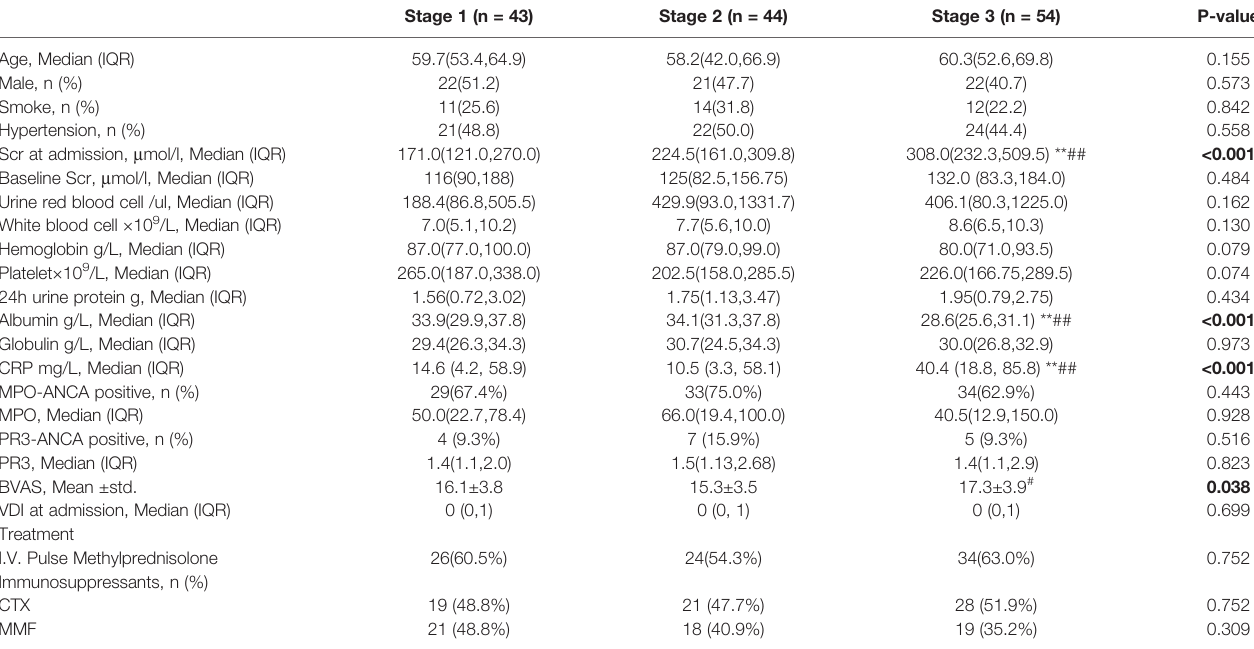
TABLE 1 | Clinical and laboratory data of AAV patients in different AKI stages.